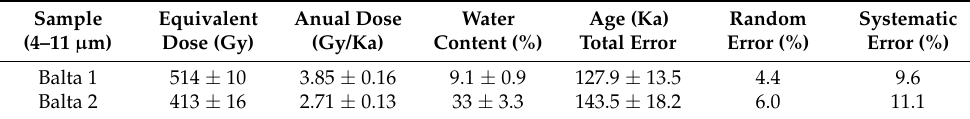
Table A5. Age Results. Alpha efficiency factor considered was 0.04 ± 0.02.